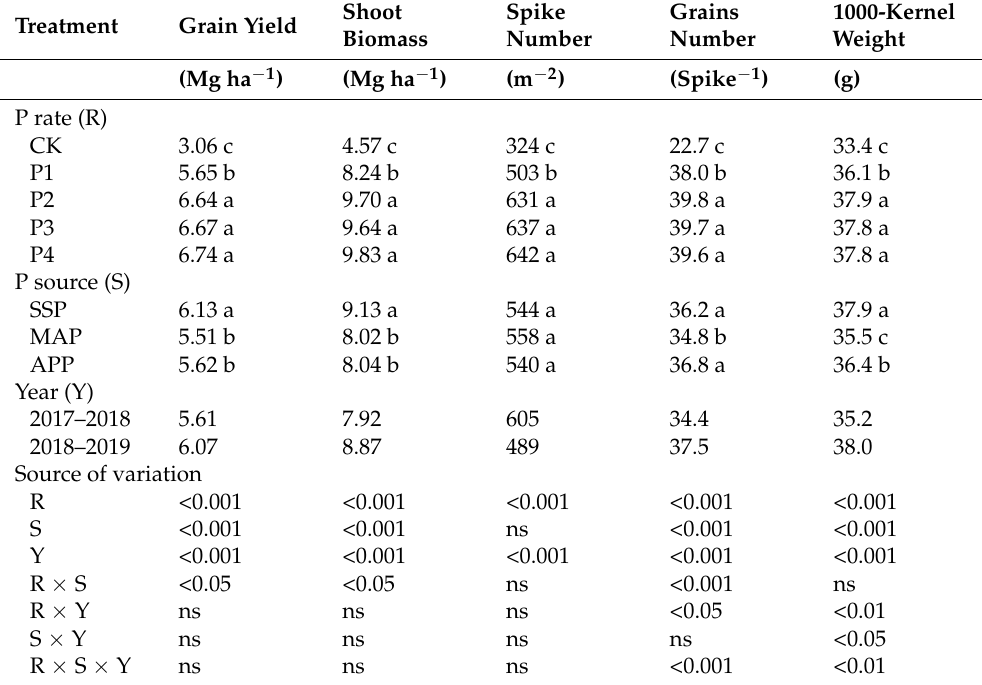
Table 3. The wheat grain yield (14.0% moisture), shoot biomass, spike number, grain number per spike, and 1000-kernel weight of maize as affected by the P rates, P sources, and years. Shoot Spike Grains 1000-Kernel Treatment Grain Yield Biomass Number Number Weight (Mg ha − 1 ) (Mg ha − 1 ) (m − 2 ) (Spike − 1 ) (g) P rate (R)